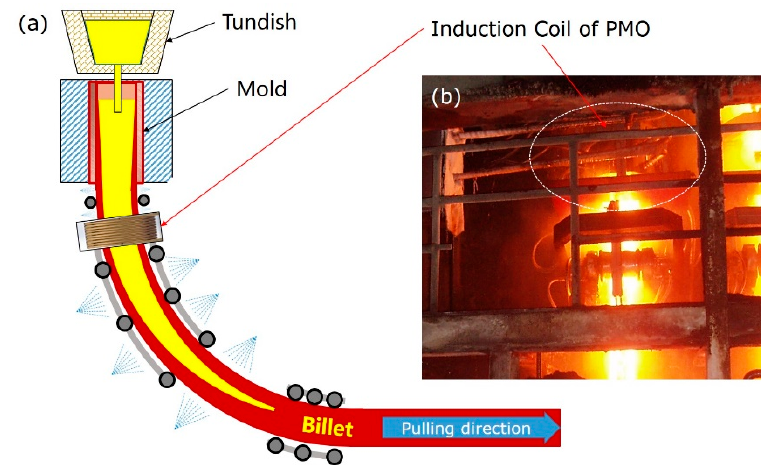
Figure 1. Schematic of the continuous caster showing ( a ) the position of the induction coil and ( b ) photo of the induction coil of PMO on the billet. Table 2. Main parameters of the continuous casting machine.